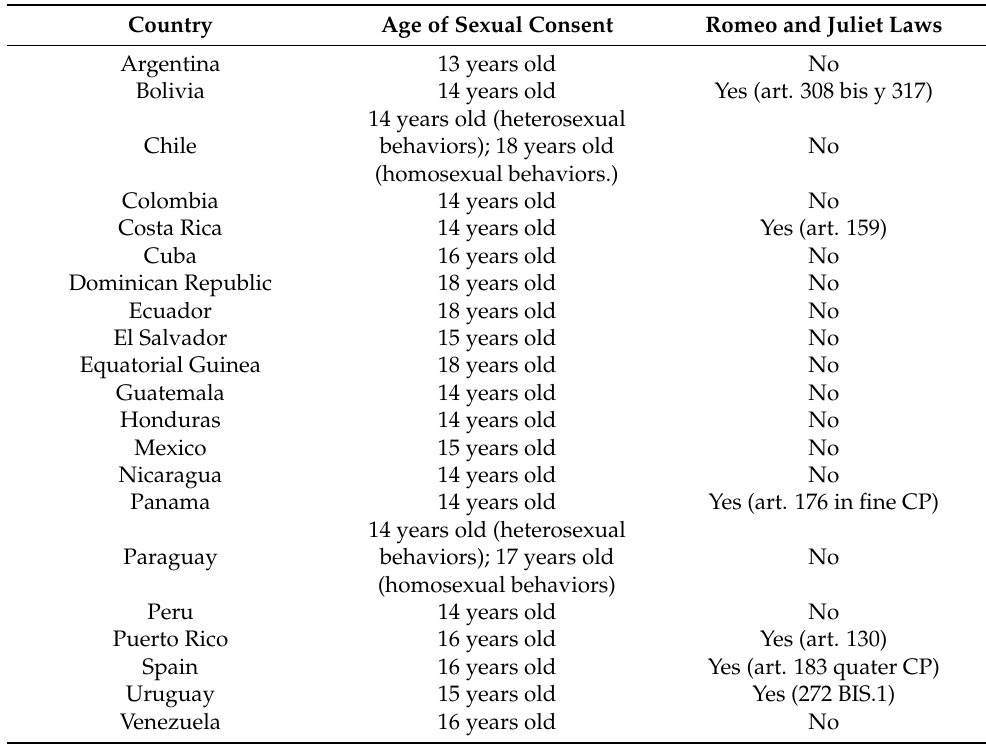
Table 2. Age of sexual consent and existence of the Romeo and Juliet laws in the legal-criminal system of Spanish-speaking